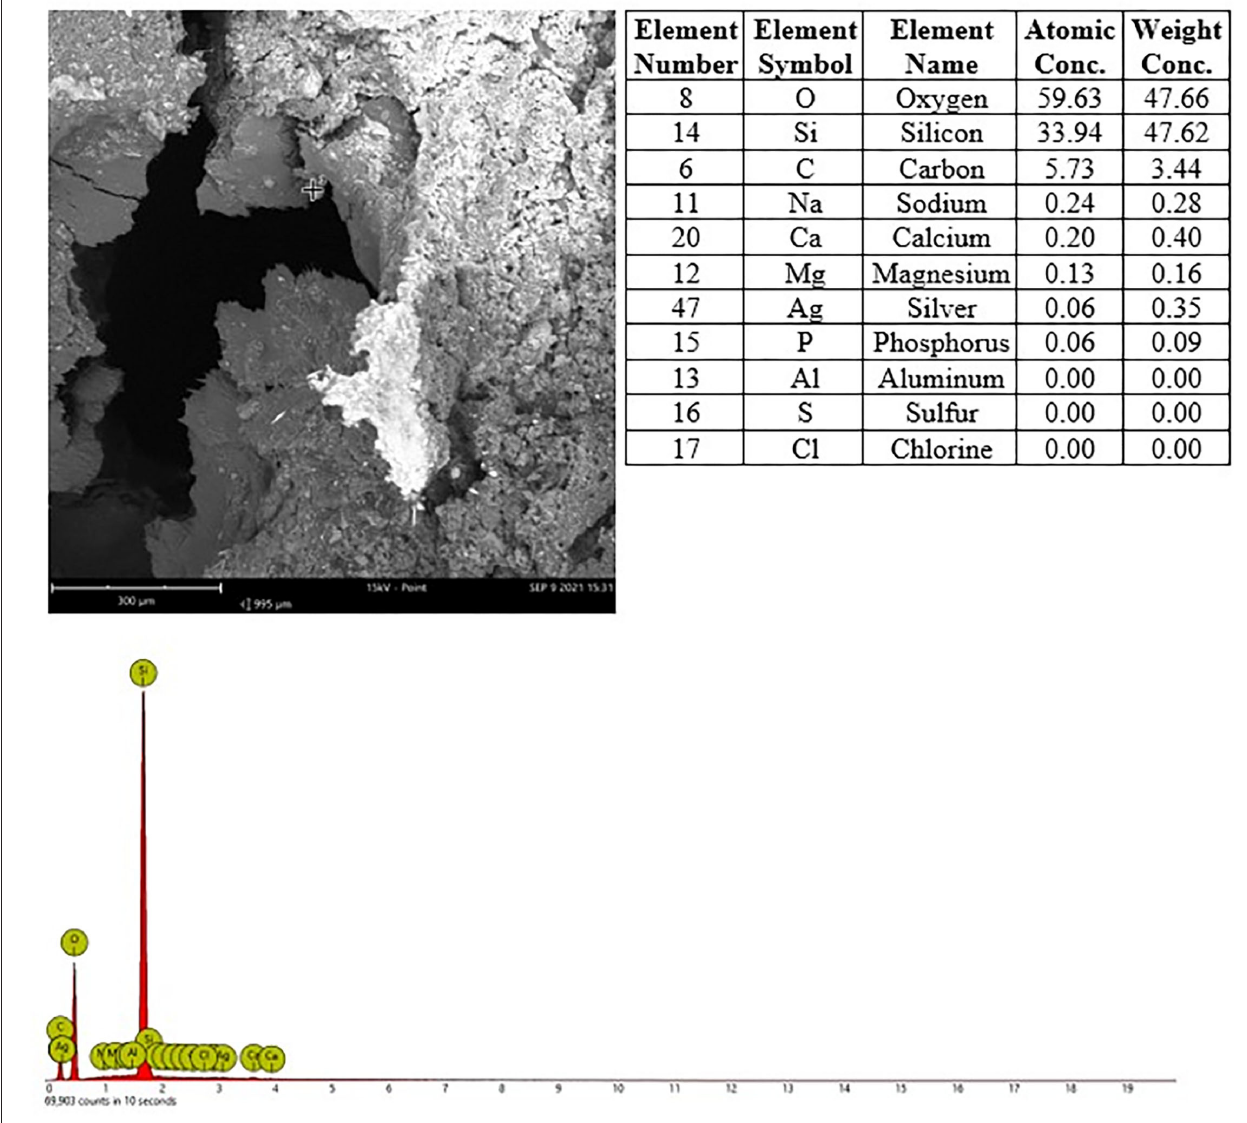
diamond blade, resin embedded and sawn again, then coated and analyzed using an identical